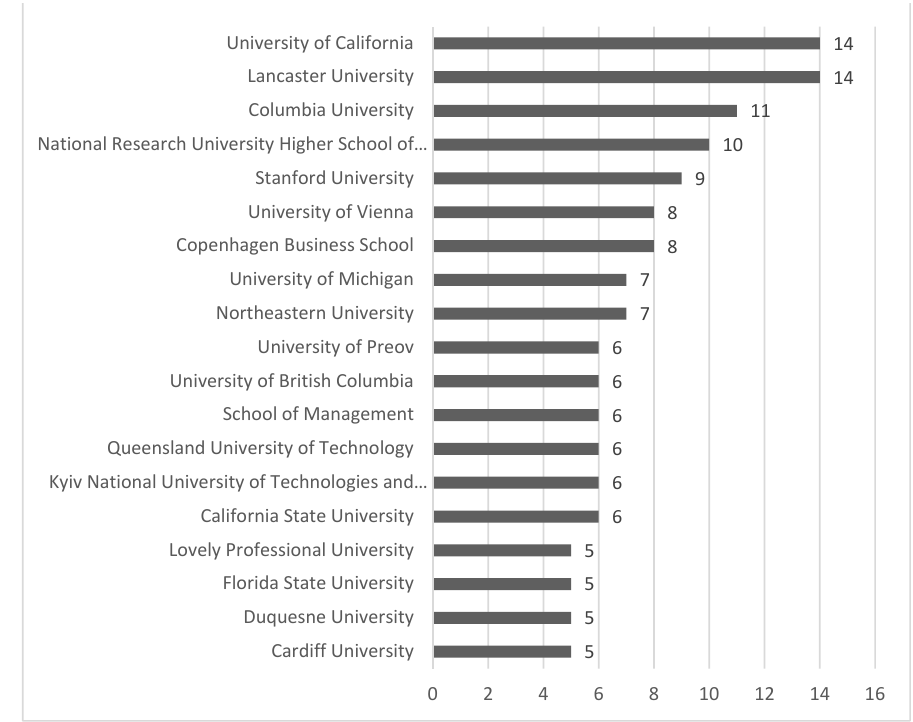
Figure 6. Leading Institutions Contributing to EVA Research (Minimum of Five Articles).